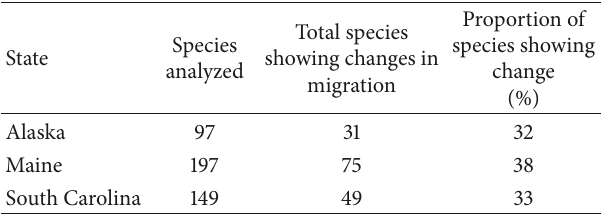
Table 1: Number of species analyzed, total number of species showing changes in migration timing, and proportion of species showing changes in migration timing by state.